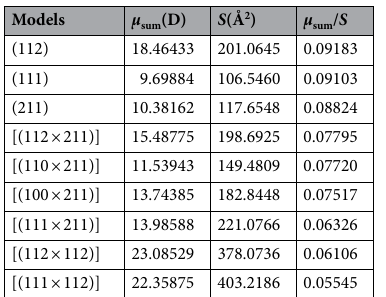
Table 2. Total dipole moments of MnO 2 bulk surface and microfacet (Debye).